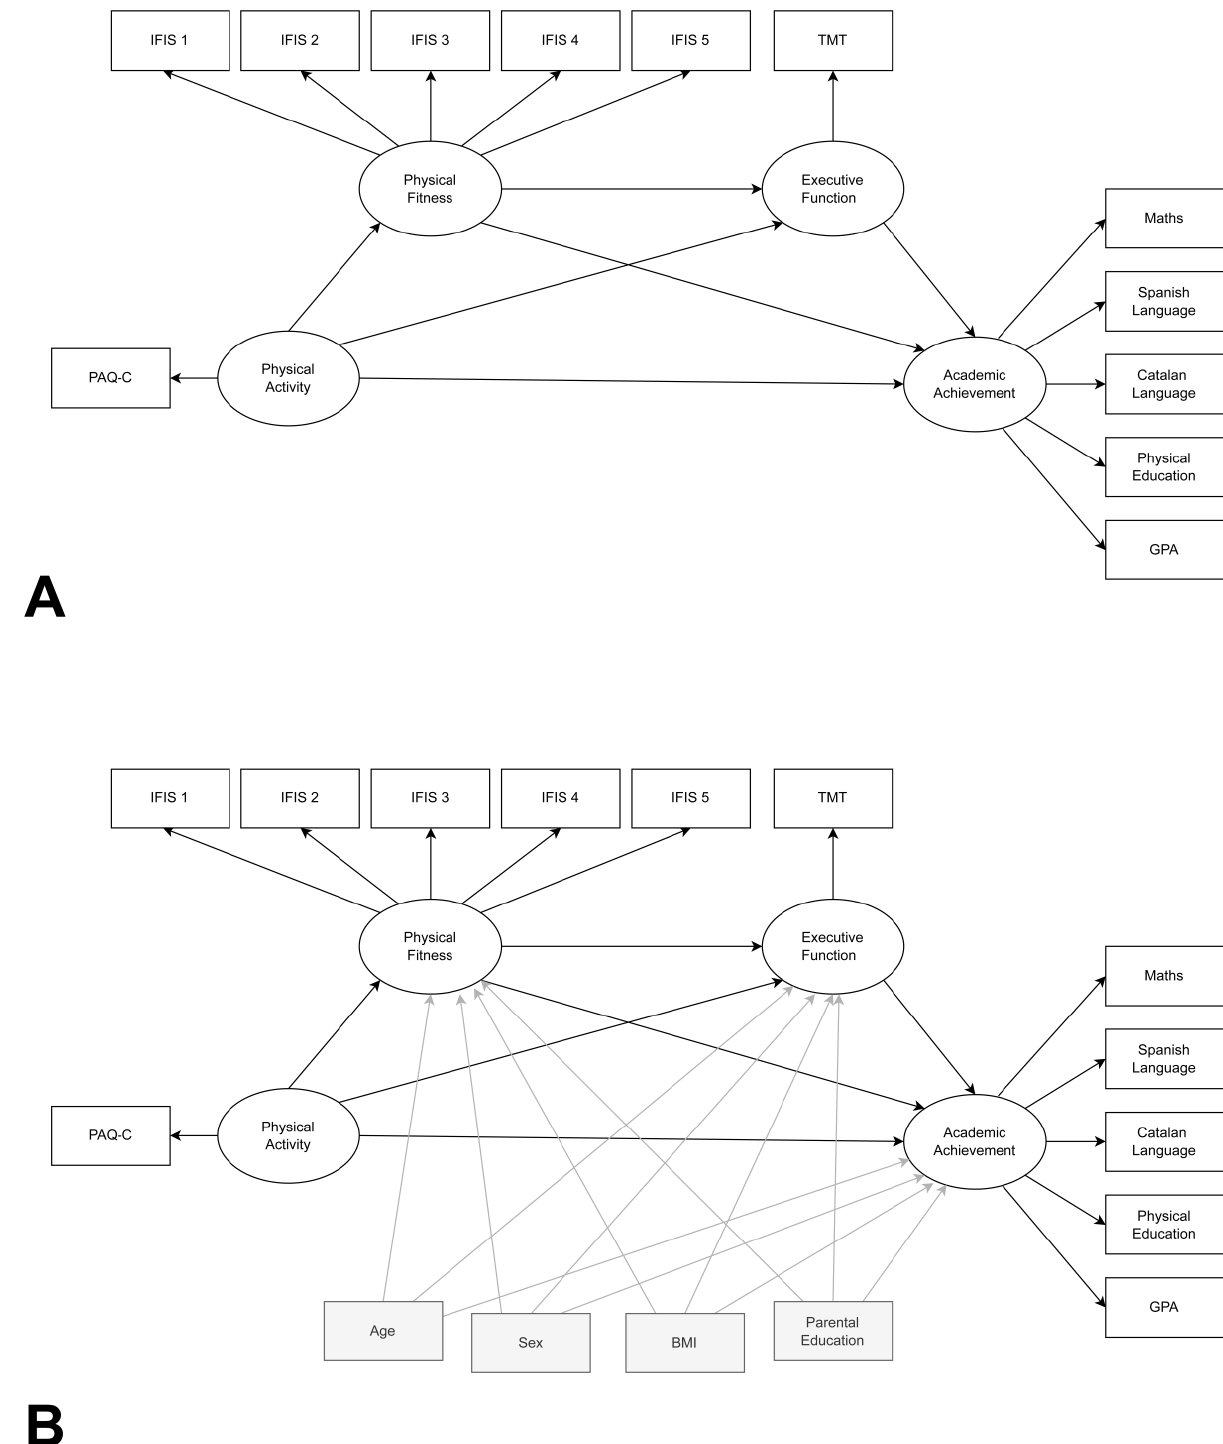
Figure 1. Hypothesised model of the relationships between physical activity, fitness, execu- tive function and academic achievement without ( A ) and with confounding variables ( B ) . Phys- ical Activity Questionnaire for Children (PAQ-C); International Fitness Scale (IFIS); Trial Making Test (TMT); Body Mass Index (BMI). IFIS 1. Overall fitness; IFIS 2. Cardiorespiratory fitness; IFIS 3. Muscular fitness; IFIS 4. Speed-agility; IFIS 5. Flexibility. Grade Point Average